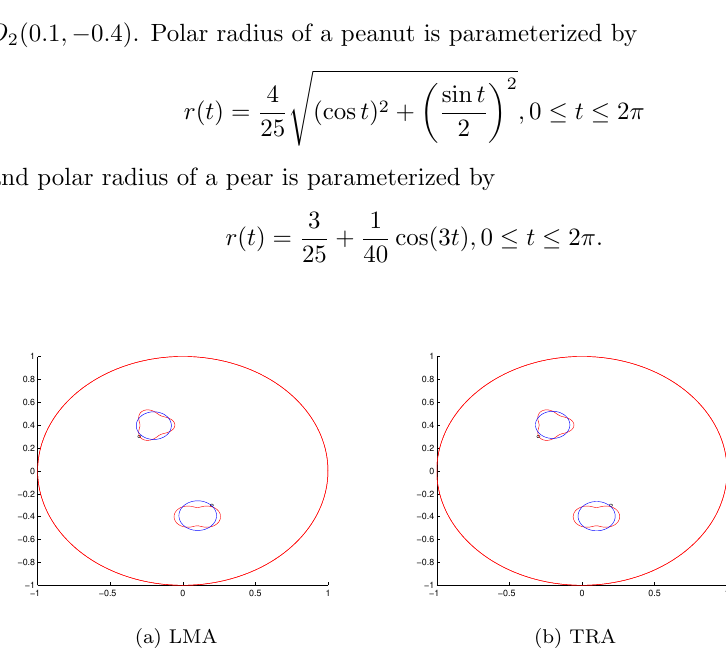
Figure 5. Apply LMA and TRA to determine the location and the size of the coefficient along with exact solution (red), initial guess (black) and recovered solution (blue), respectively for Example 3